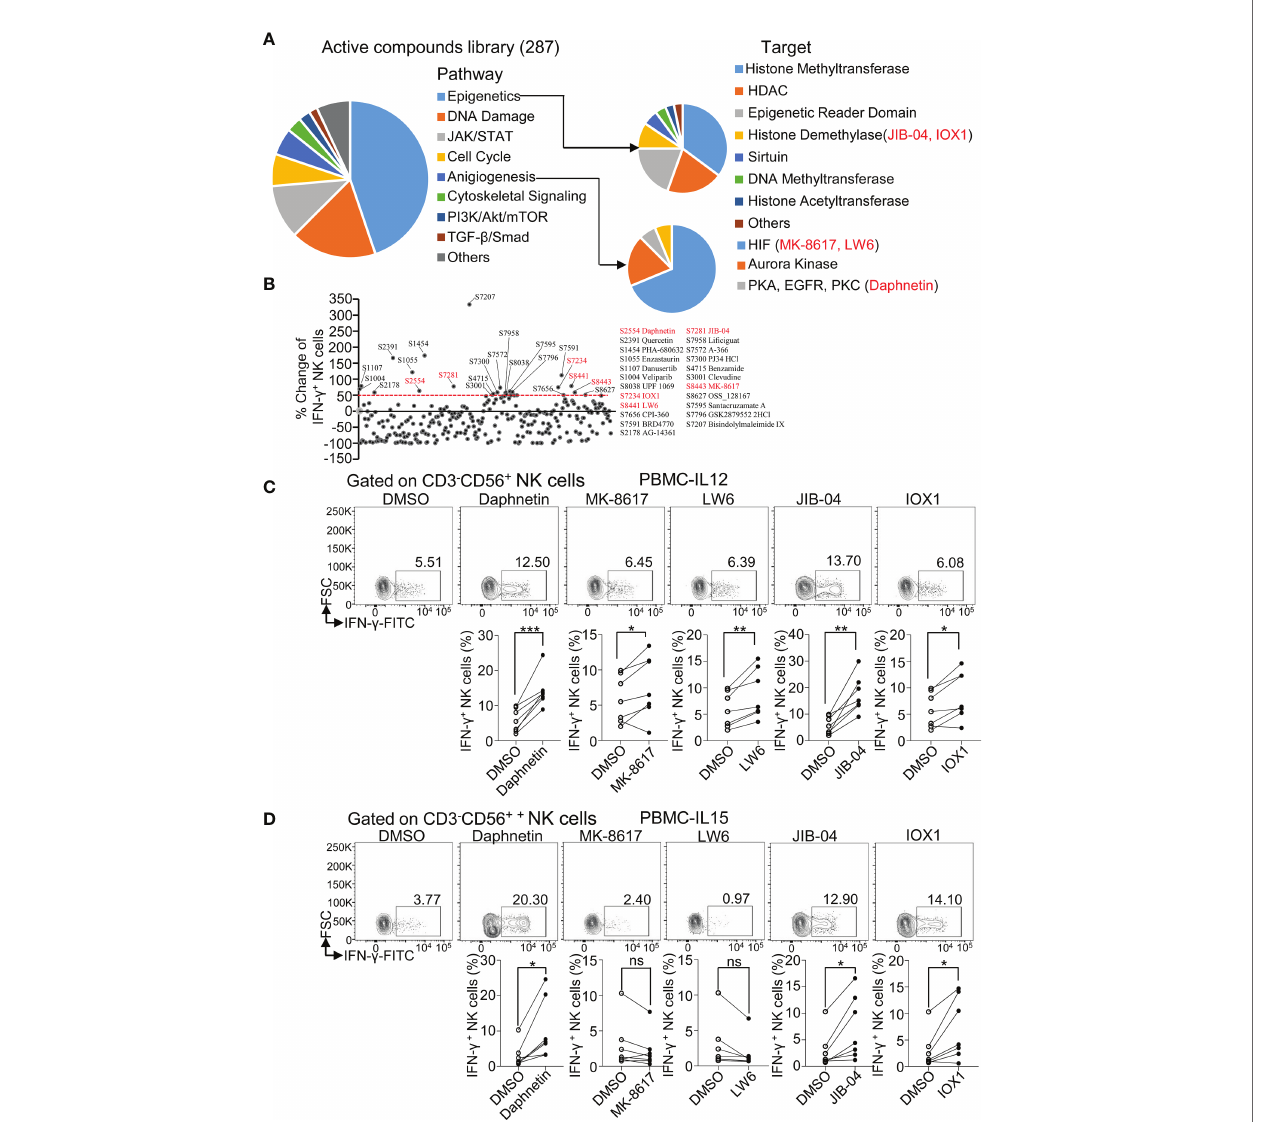
FIGURE 1 | Active compound screening of human NK cell activator via determining IFN- g production. (A) Summarization of 287 active compounds based on their molecule targets. (B) Distribution of percent change of IFN- g -producing NK cells treated by the 287 active compounds in the presence of IL-12 (10 ng/ml) for 18 h Twenty-three active compounds that increased more than 50% in IFN- g + ratio in NK cells than DMSO control were labeled with their catalog numbers. (C, D) Flow cytometric analysis and cumulative frequencies of IFN- g -producing NK cells after healthy donor PBMCs treated by DMSO or indicated active compounds in the presence of IL-12 (10 ng/ml) (C) or IL-15 (10 ng/ml) (D) , for 18 h Each dot represents one donor. Paired t -test was applied between two different treatment and the signi fi cant level was shown as * p < 0.05, ** p < 0.01, *** p < 0.001, ns, not statistically signi fi